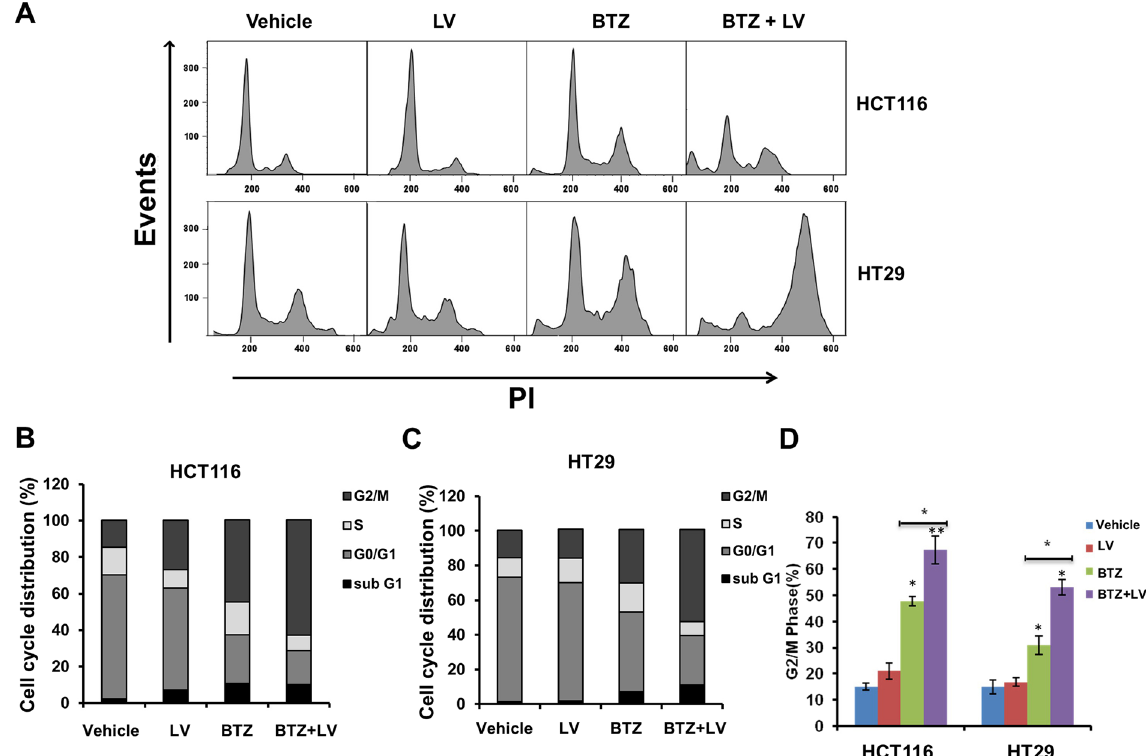
Figure 3. The combination of bortezomib and leucovorin induced G2/M arrest in CRC cells. ( A ) Colon cancer cells were treated with 10 nM bortezomib and/or 10 µ M leucovorin or appropriate concentration of vehicle control for 24 h. The cells were harvested, washed with PBS, typsinized, fixed overnight with 70% ethanol at − 20 °C, and stained with PI solution before being subjected to flow cytometry. Cell cycle distribution analysis was performed using FlowJo. (B , C) Histogram showing the percentage of HCT116 and HT29 cells in the sub- G1, G0-G1, S, and G2/M phases. ( D) Representative cell cycle histogram demonstrating the percentage of cells in the G2/M phase. * P ≤ 0.05. ** P ≤ Each experiment was performed four times, and values are presented as the mean ±